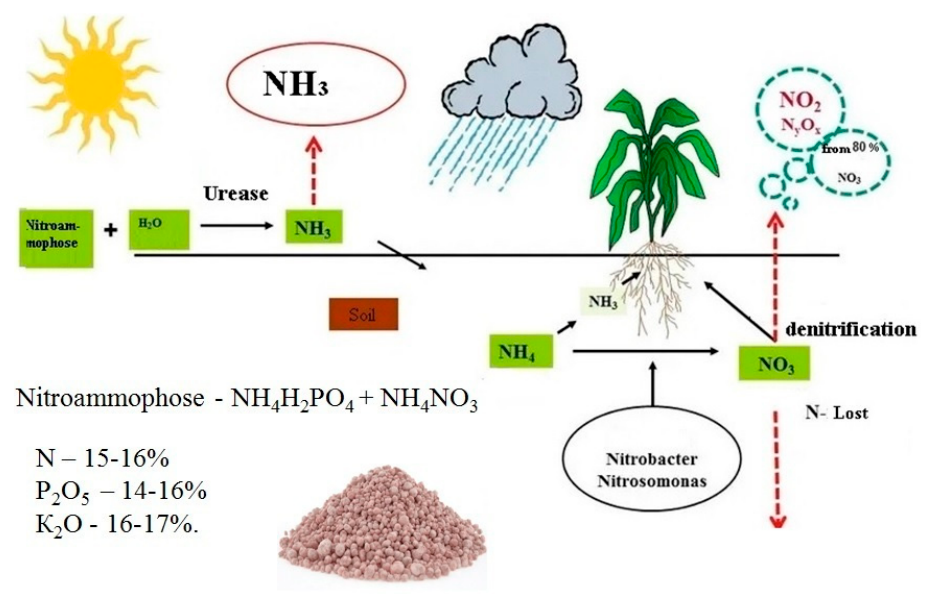
Figure 2. The process of denitrification of nitroammophos in soil. Nitrate ions (NO 3 − ) are absorbed by plants and microorganisms only within the vegetation period for biological purposes. In the autumn and winter period, nitrate ions migrate with descending water flows from the root-containing layer, which results